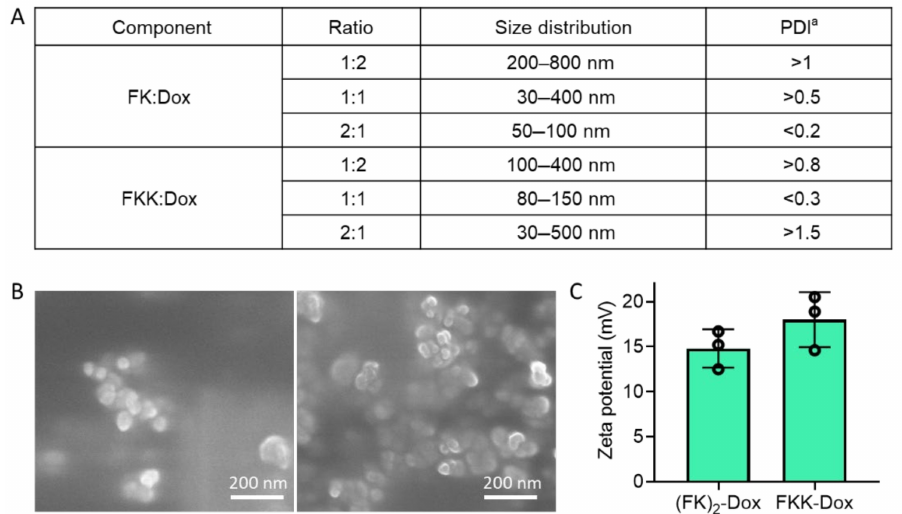
Figure 3. ( A ) Summary of the component ratio used in this study and the resulting size distribution and polydispersity index (PDI) of di ff erent components. a The value represents the mean of three times of replication. ( B ) SEM images of (FK) 2 -Dox (left) and FKK-Dox (right). ( C ) Zeta potentials of (FK) 2 -Dox and